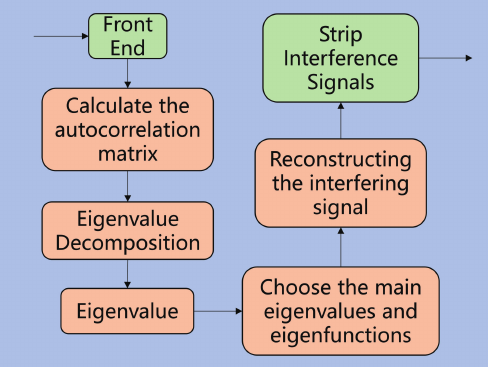
Figure 4. The processing of KL decomposition algorithm.